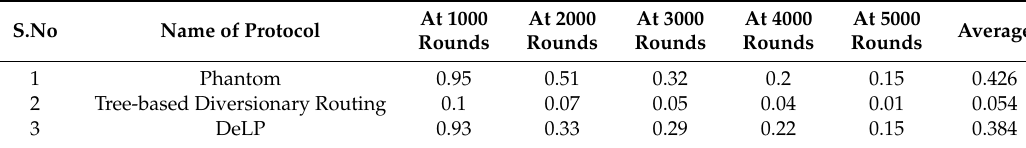
Figure 11. Delivery ratio Vs Network lifetime (rounds). Table 3. Comparison of packet delivery ratio after equal intervals.